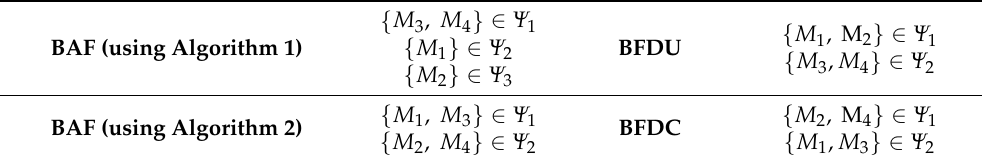
Table 3. Task Mapping Example